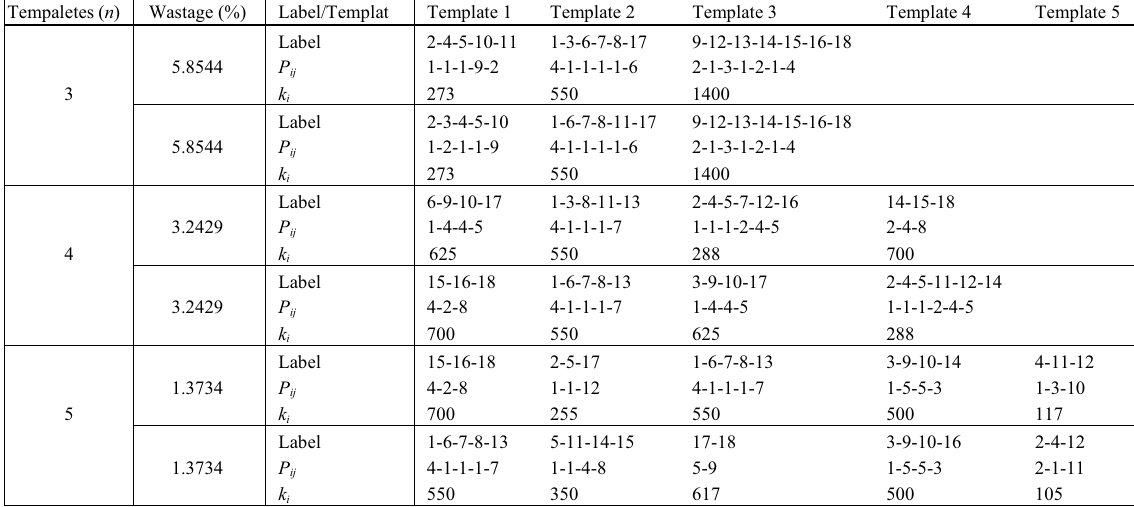
Table 3. Multiple solutions of test problem 1 by